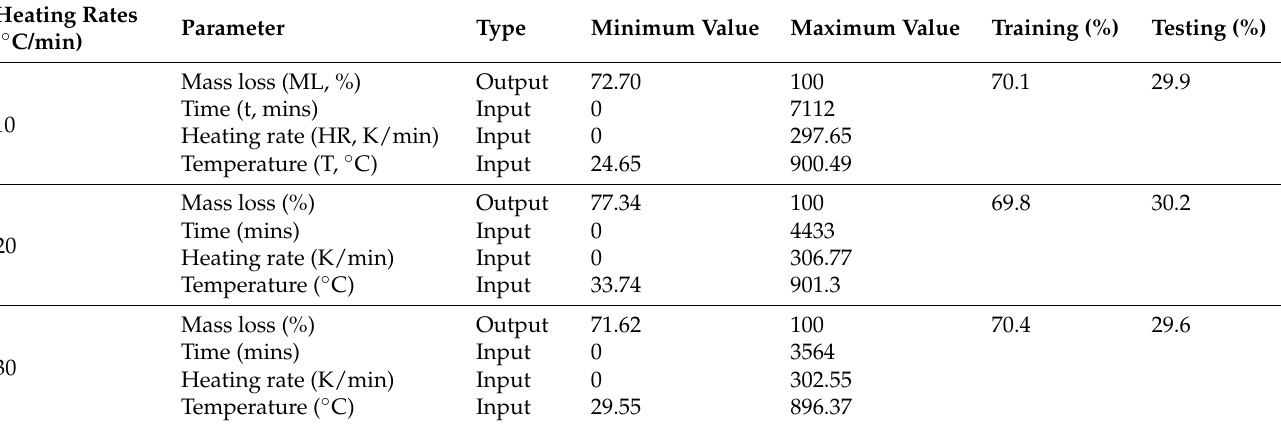
Table 1. The range of data employed in MLP ANN and % of input data used for training and